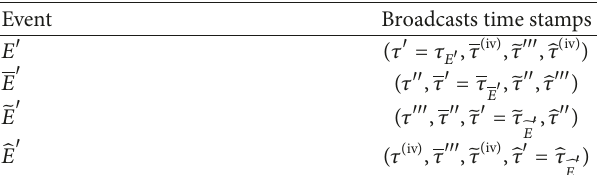
耠 ̃𝐸 耠 ̂𝐸 耠 , , and and their broadcast time